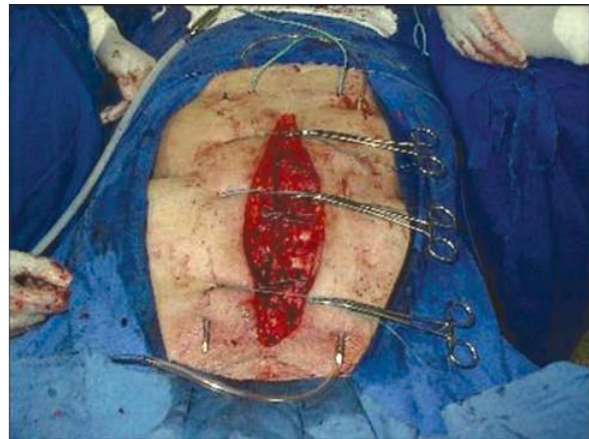
Fig. 4 - Aproximação dos bordos com pontos totais ancorados nos fios de Kirschner